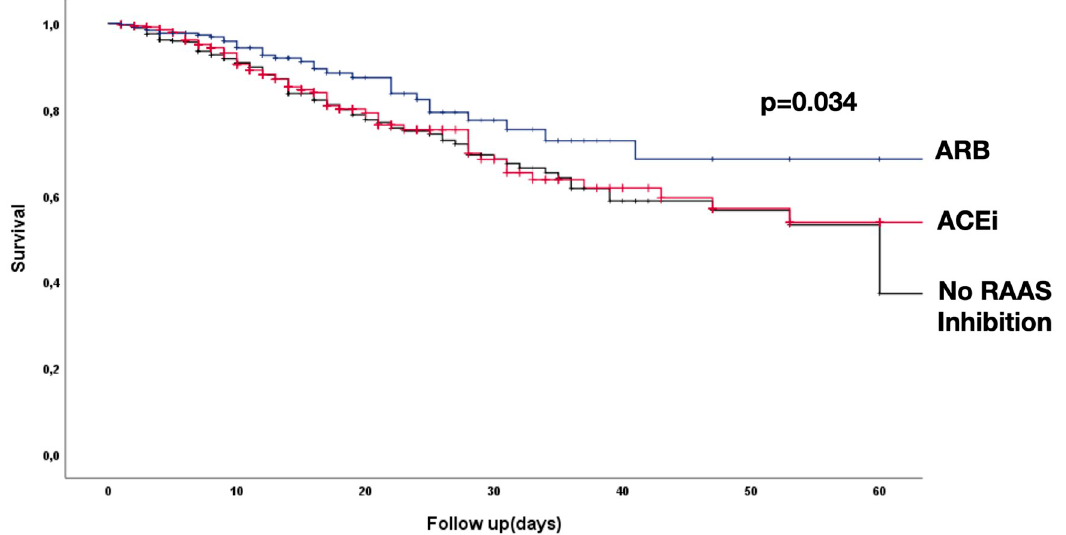
Fig 3. Kaplan-Meier analysis, patients with CVD and/or hypertension, baseline uncomplicated. Association between intake of RAAS- modulating drugs and mortality by Kaplan–Meier analysis in patients in the uncomplicated phase. P -value is for log-rank test, n =